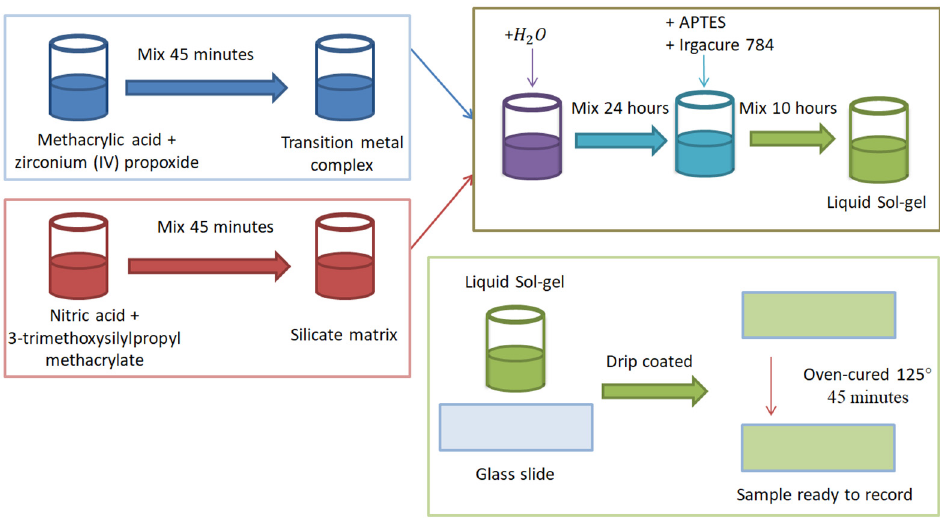
Figure 4. Illustration of the photosensitive sol–gel layer preparation procedure.